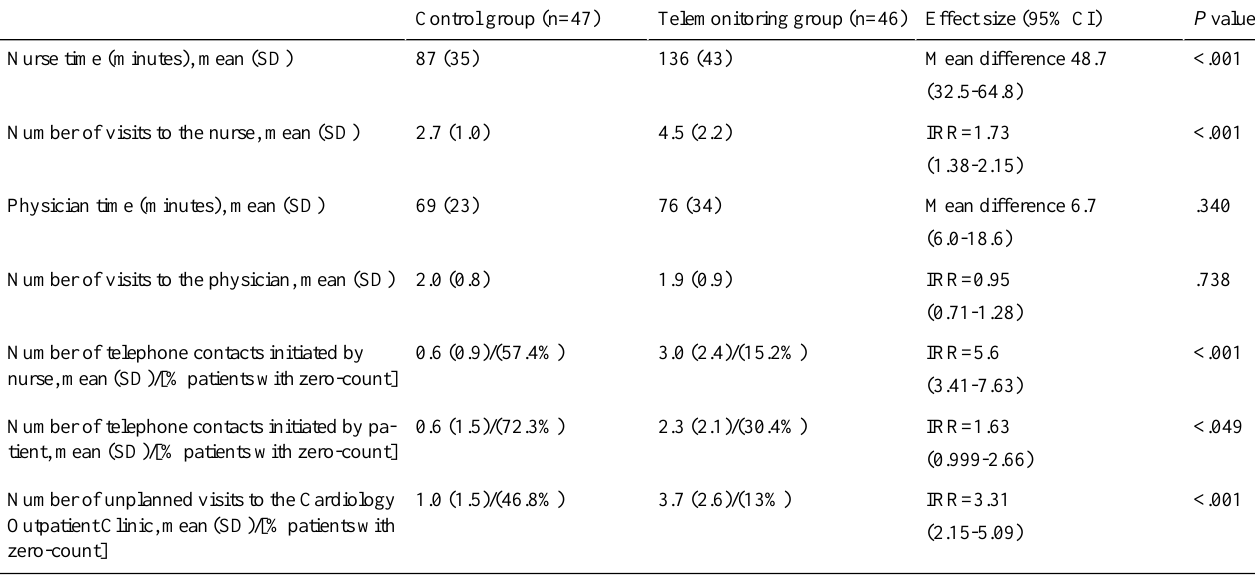
Table 4. The use of health care resources per patient during the